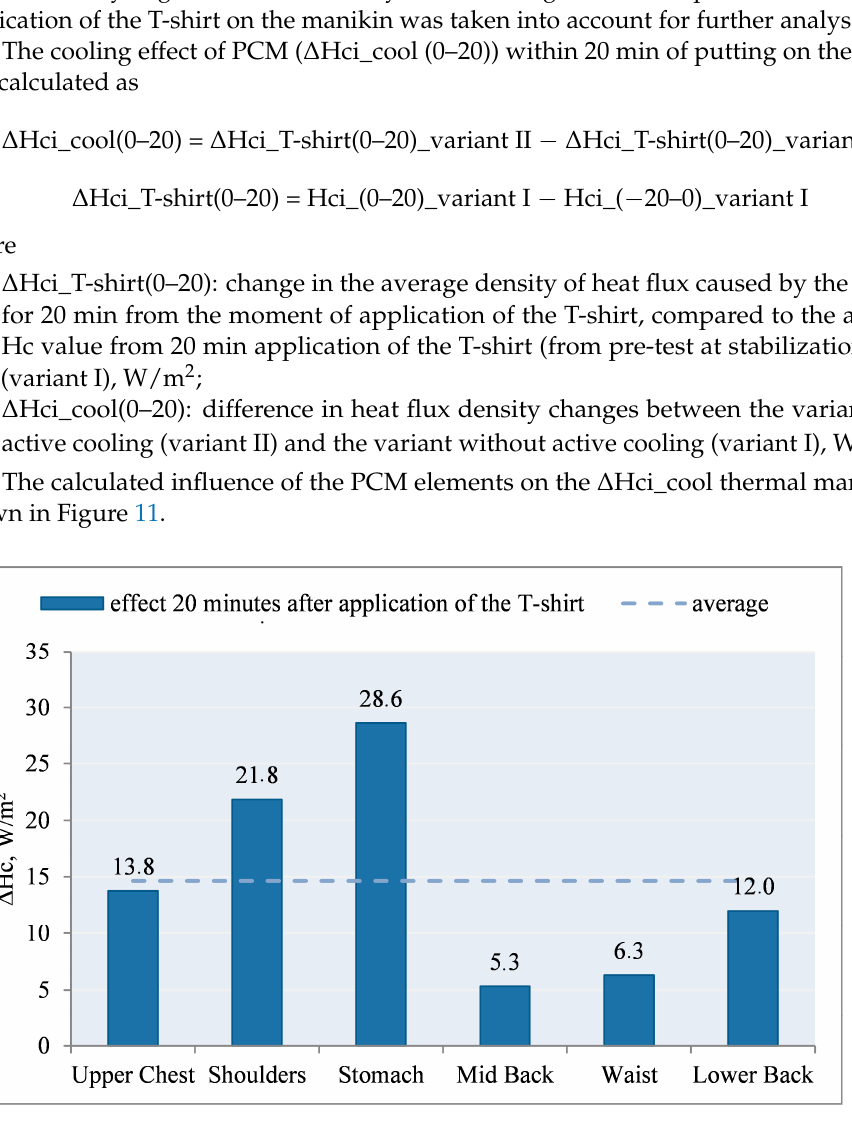
Figure 11. Influence of PCM elements on the thermal manikin: difference in the density of heat fluxes Δ Hci_cool 20 min after application of T-shirt on the selected manikin segments for the values obtained for variants I and II.